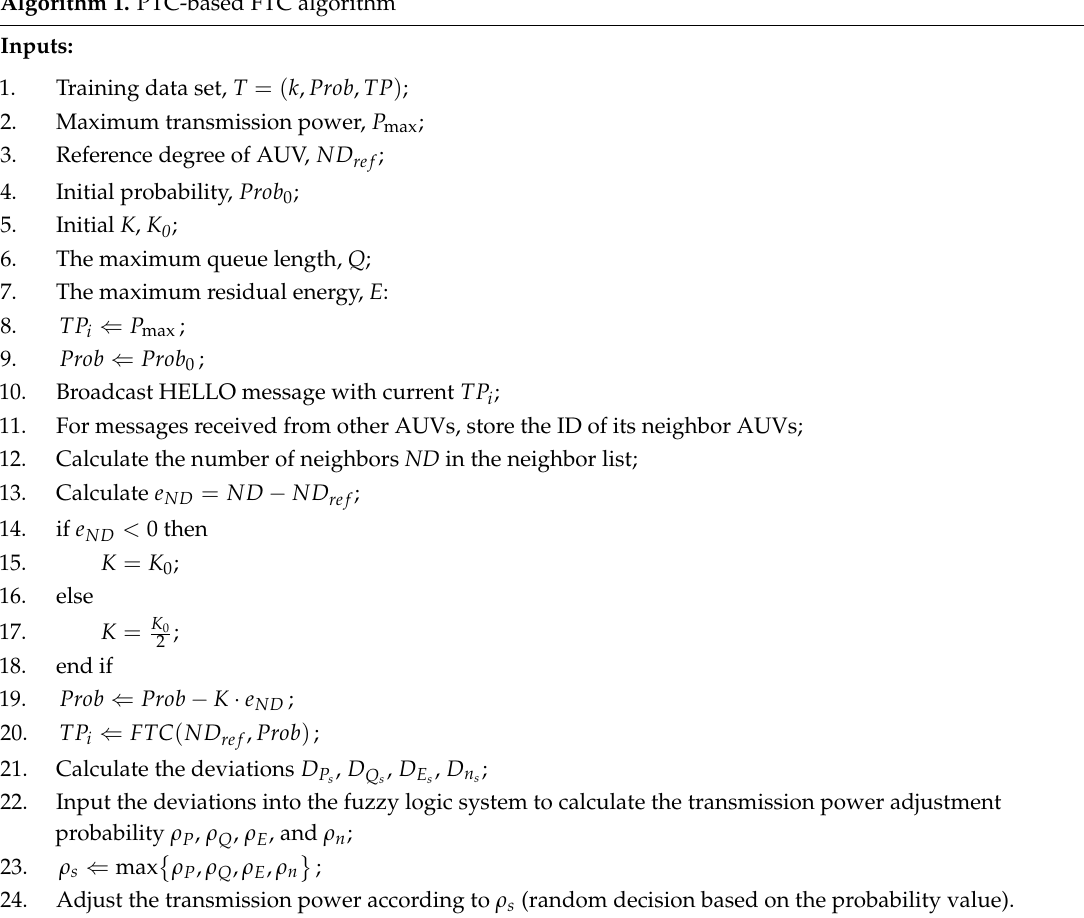
Algorithm 1. PTC-based FTC